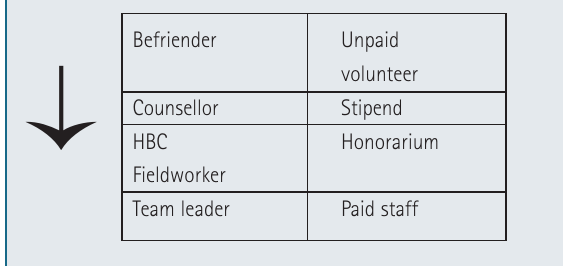
Fig. 1. Creating a ‘career path’ for